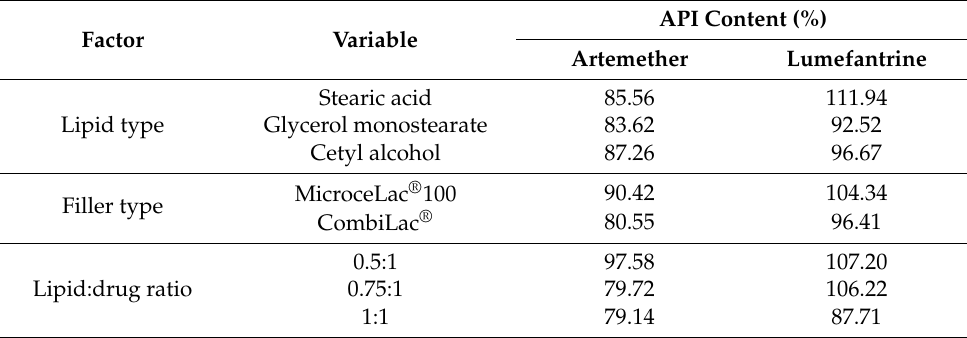
Table 3. Percentage of active pharmaceutical ingredient (API) content, presented as an average per factor